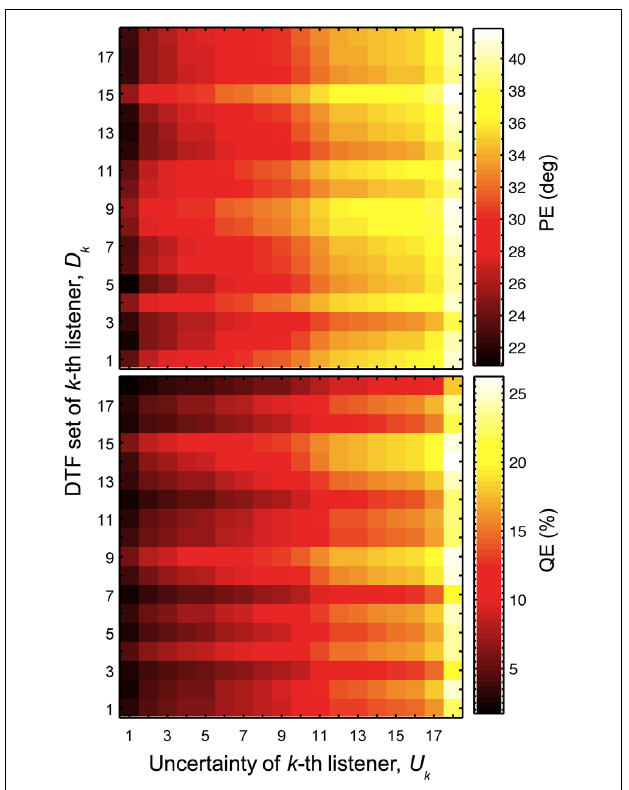
FIGURE 5 | Localization performance depends on the uncertainty and DTF set. Predicted PEs and QEs as functions of the uncertainty of k -th listener ( U k ) and DTF set of k -th listener ( D k